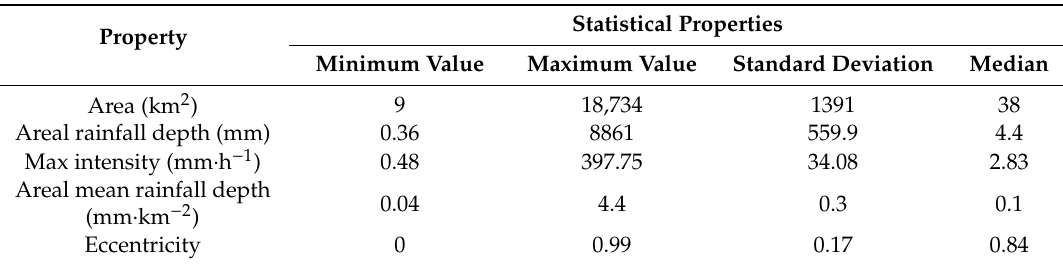
Table 2. Descriptive statistics of rain cell properties. Indexes used for the statistics are minimum value, maximum value, standard deviation, and median